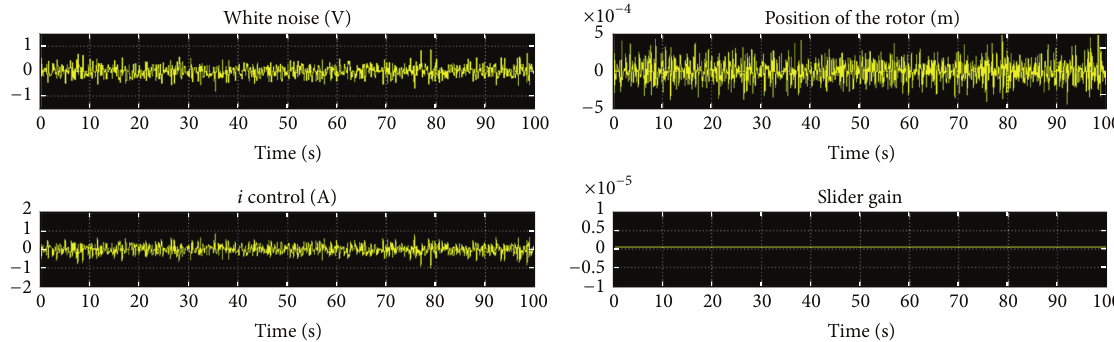
Figure 19: System response with PID controller with proportional gain of 1526.6269, integral gain 13330.5096, and differential gain of 15.8724 and white noise of 0.01